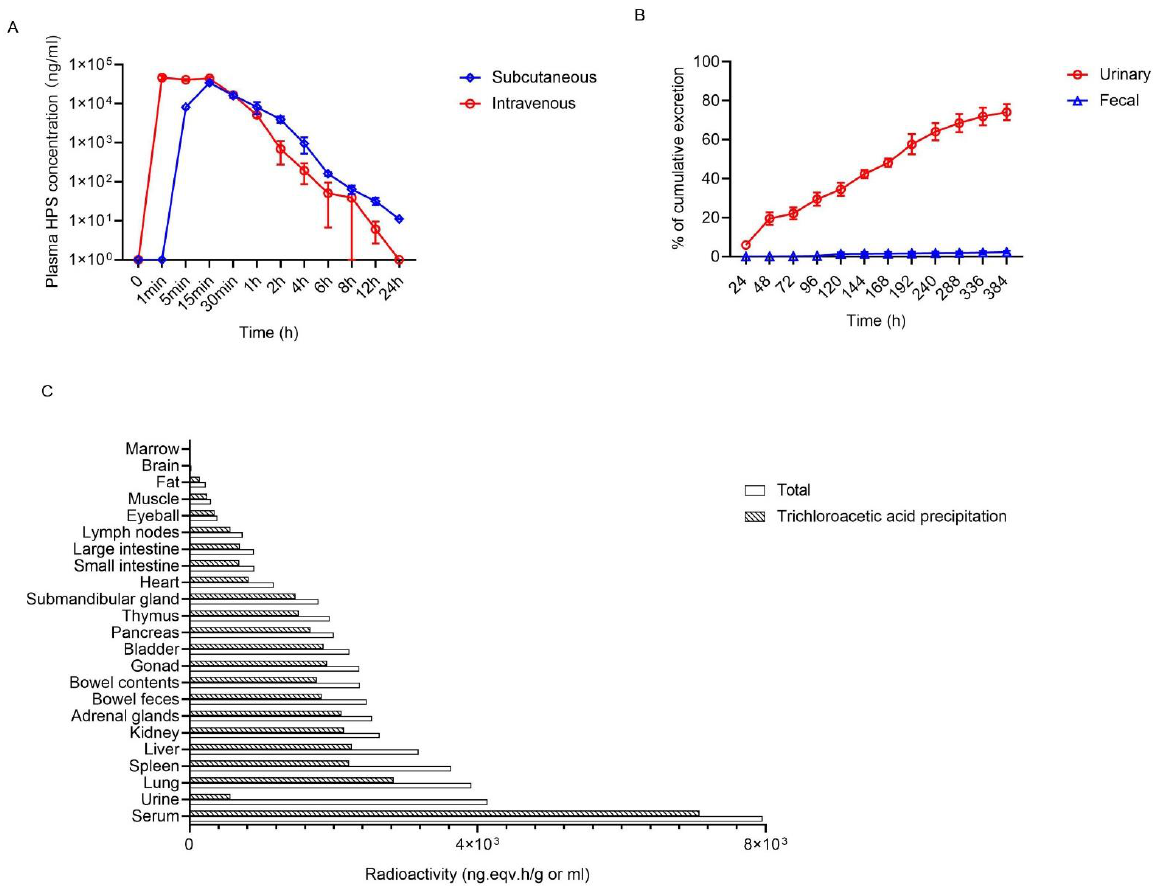
Figure 5. The pharmacokinetics of HPS. ( A ) Plasma concentration-time profiles after intravenous or subcutaneous adminis- tration of HPS (3.5 mg/kg) in rats ( n = 3/group). Data are presented as the mean ± SD. ( B ) Tissue distribution of HPS after intravenous administration in rats ( n = 5/group). ( C ) Cumulative urinary excretion and fecal elimination as a percent of dose administrated ( n = 6/group).